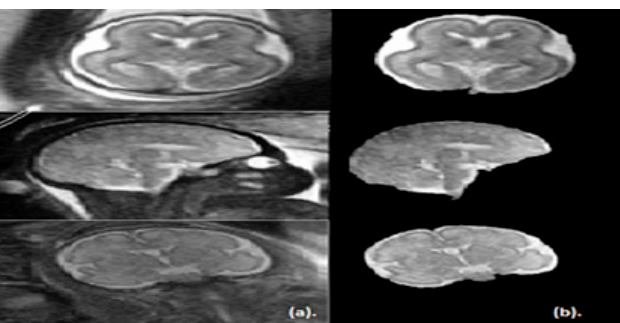
Figure 4. The fetal brain images in the sagittal, coronal, and axial planes. ( a ) Before segmentation and ( b ) after the proposed segmentation step.